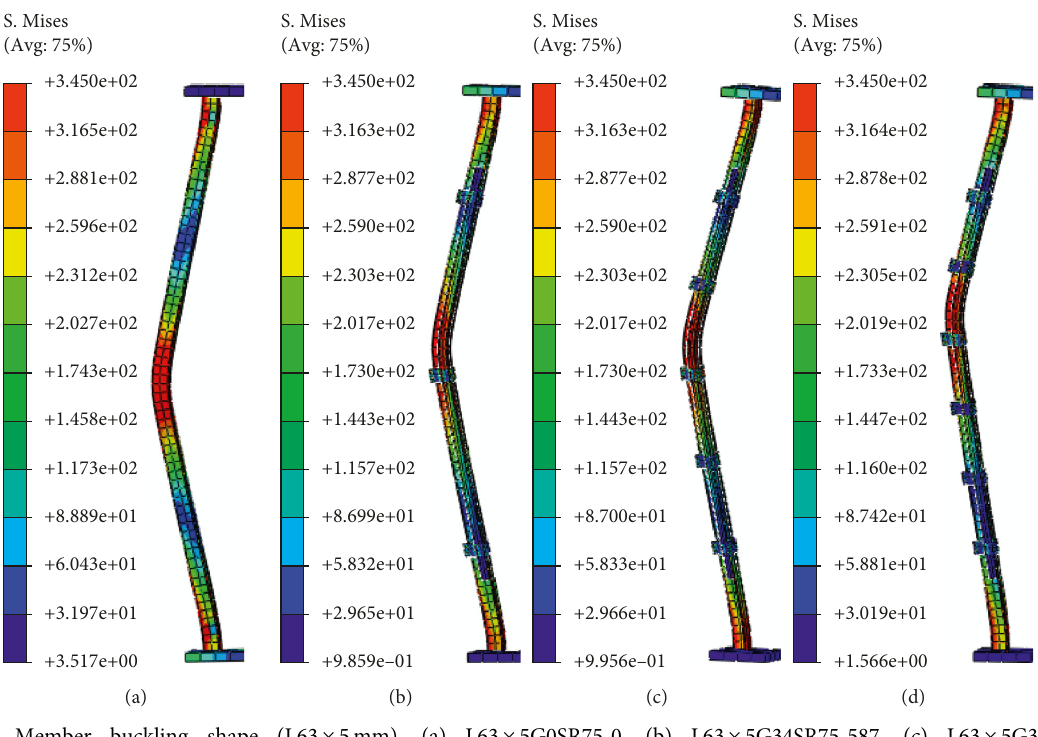
Figure 6: Member buckling shape (L63 × 5 mm). (a) L63 × 5G0SR75-0. (b) L63 × 5G34SR75-587. (c) L63 × 5G34SR75-295. (d) L63 × 5G34SR75-235.